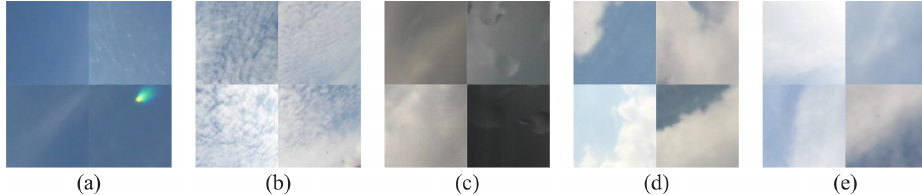
Figure 2. Sample images from the SWIMCAT dataset. The dataset includes five cloud types, namely, (a) clear sky, (b) patterned clouds, (c) thick dark clouds, (d) thick white clouds and (e) veil